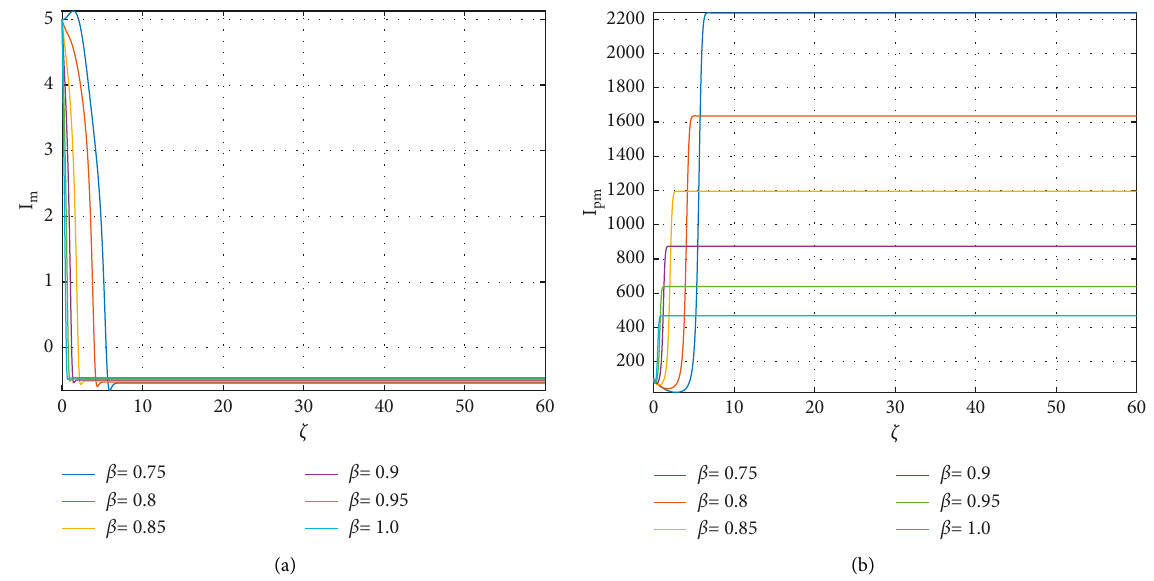
Figure 5: Two-dimensional illustration of the meningitis infectious I orders β ∈ [ 0 , 1 ]